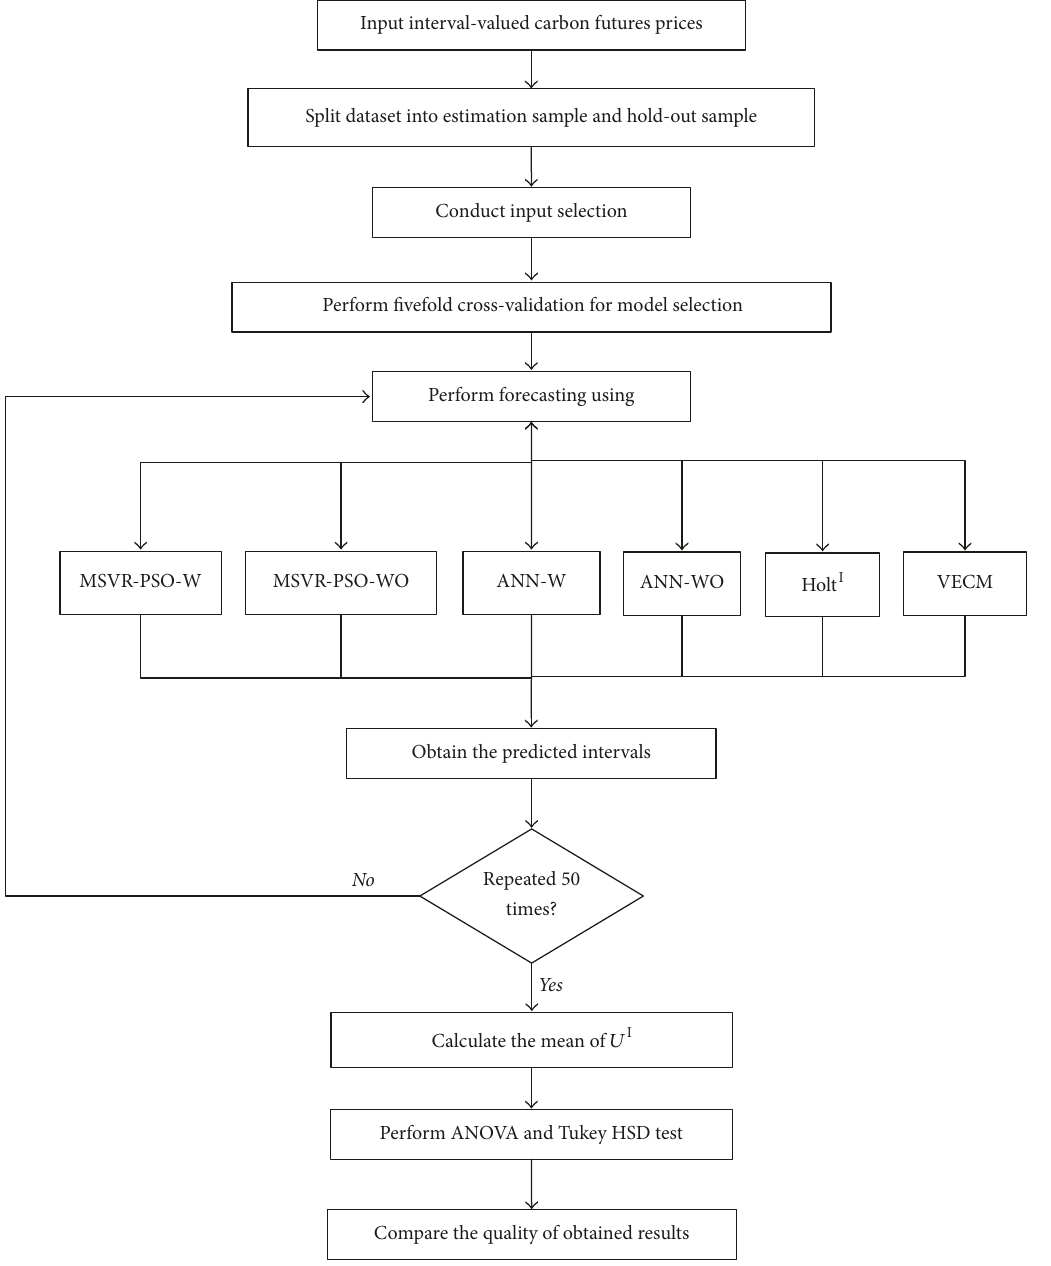
Figure 9: Experimental